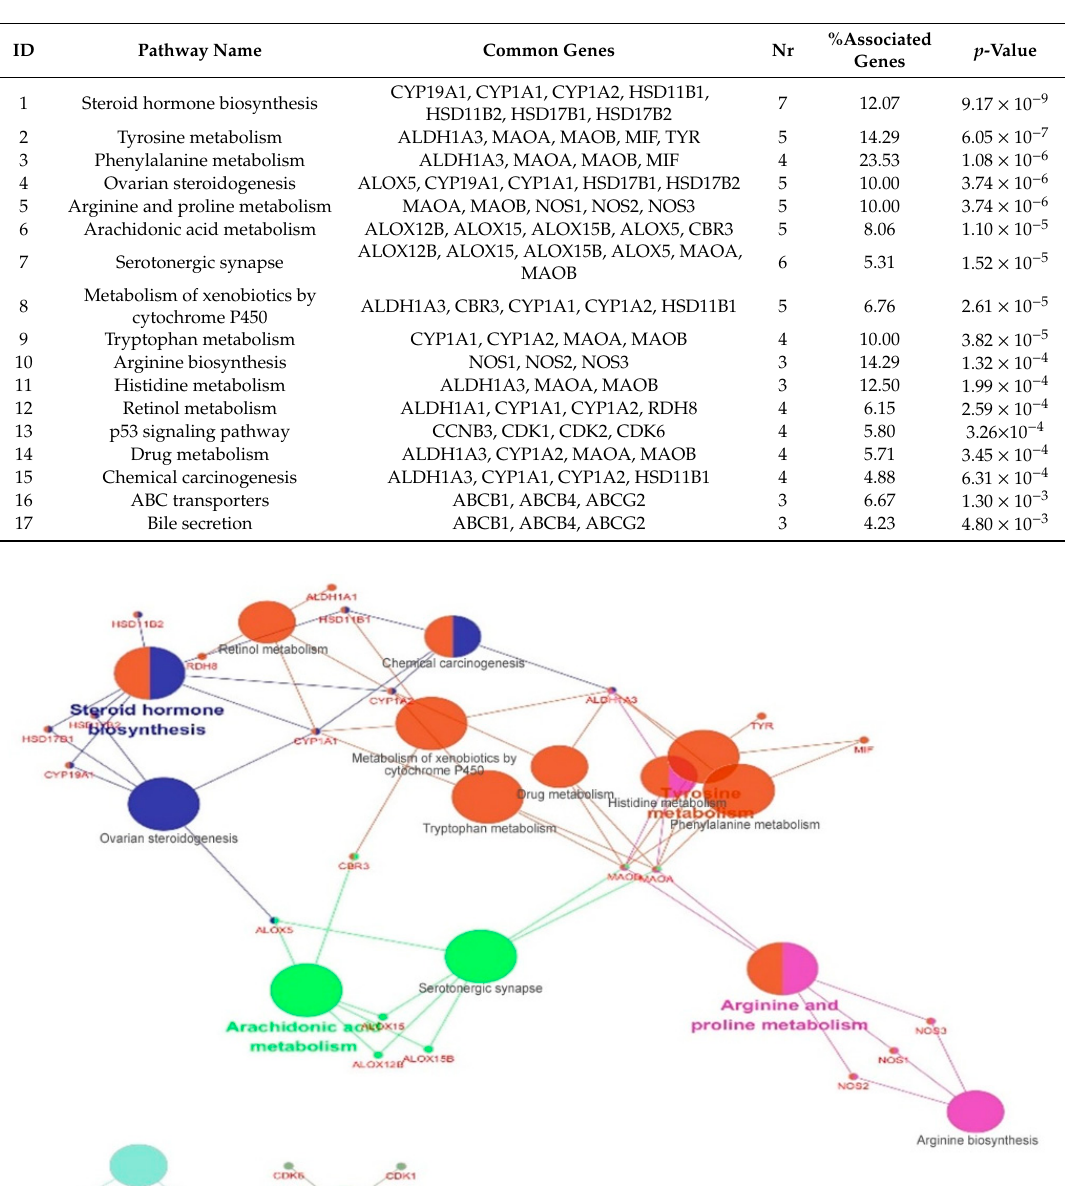
Table 4. Seventeen KEEG pathways enriched by 49 potential targets of licorice with p -value less than 0.01.